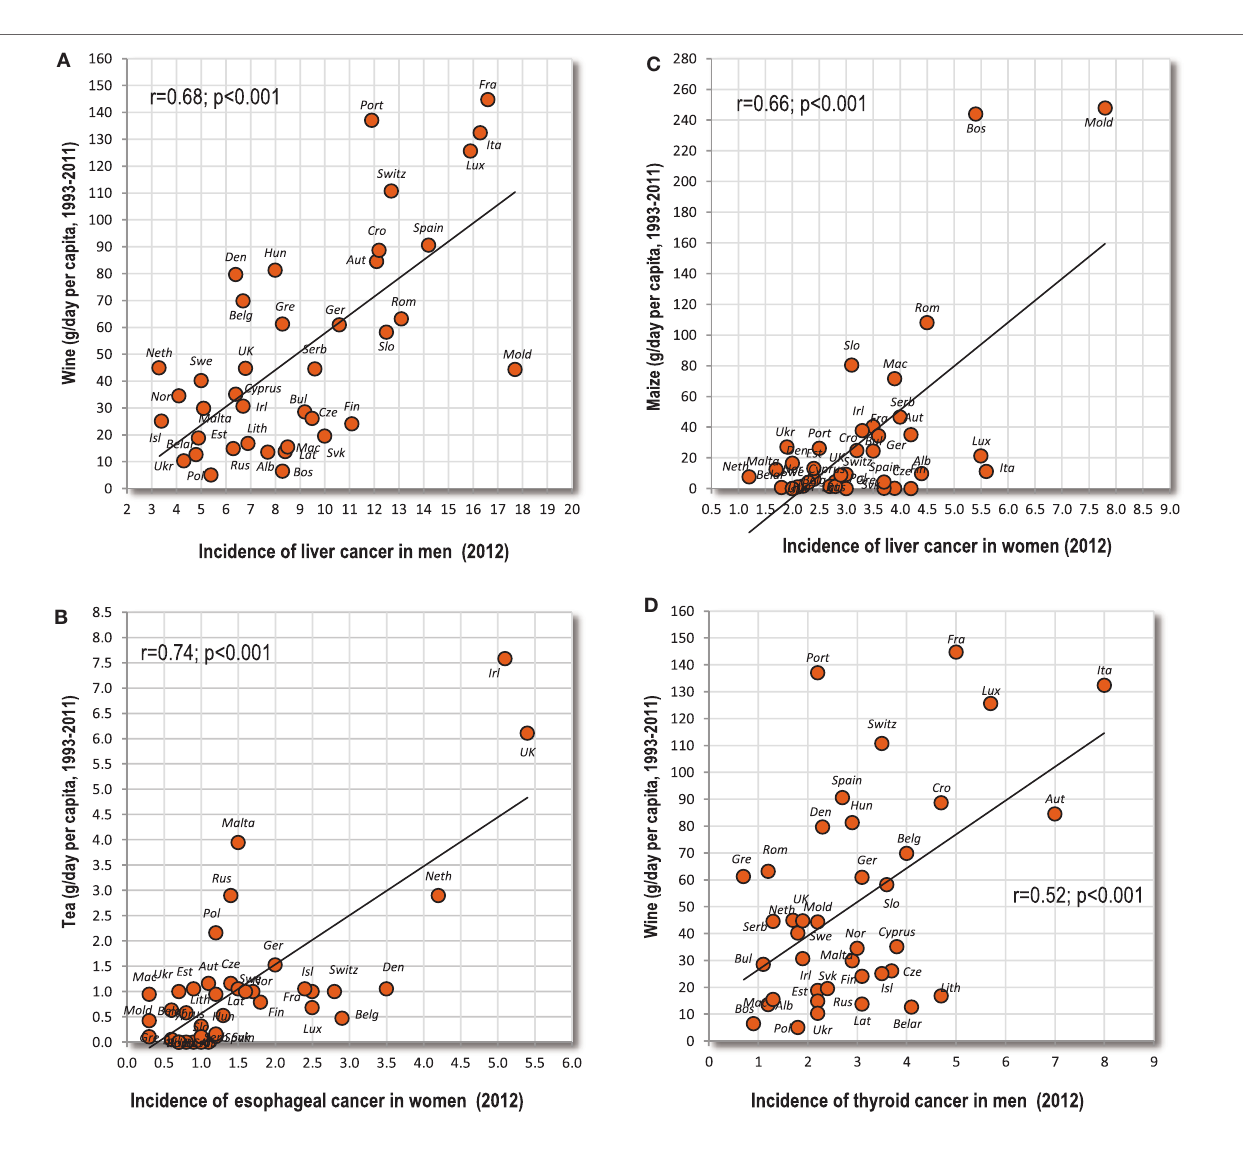
FigUre 5 | (a–D) Relationship between some types of cancer and highly correlated independent